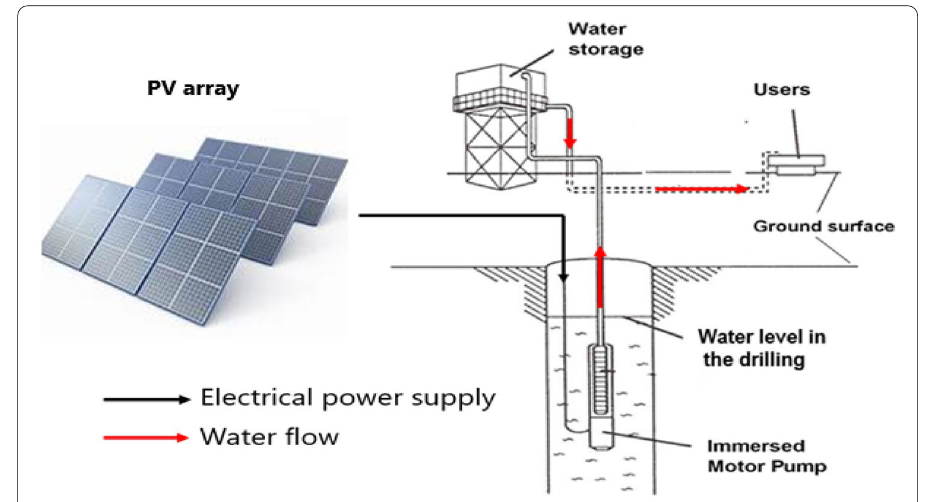
Fig. 1 Stand-alone photovoltaic water pumping system without energy